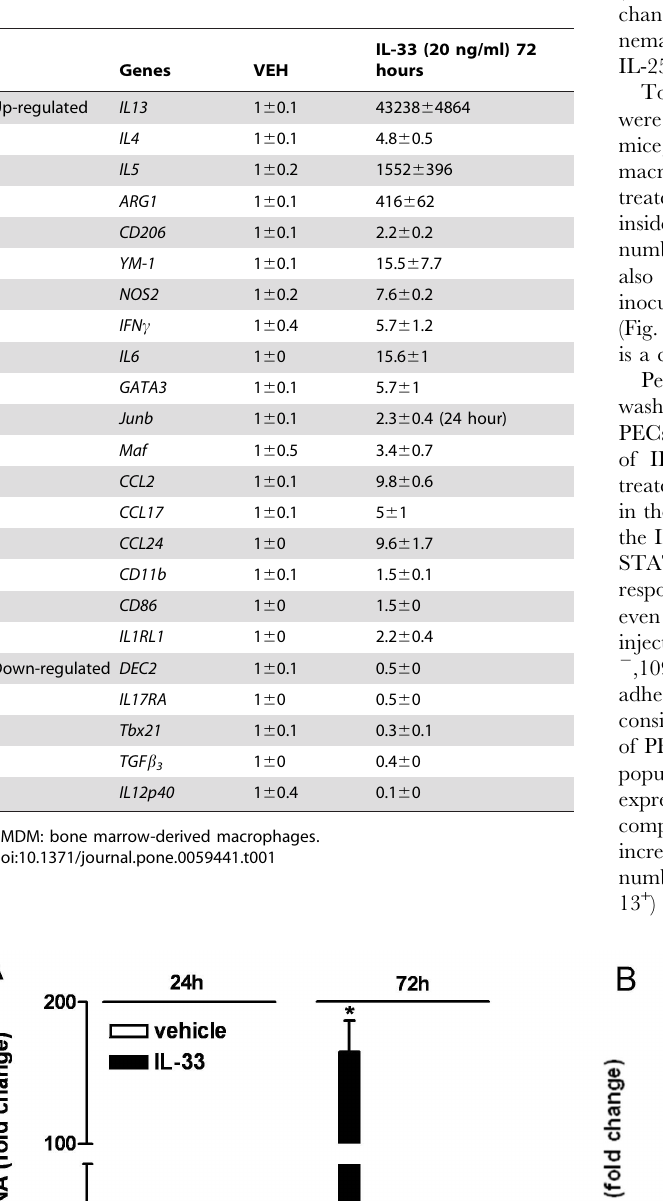
Table 1. Genes regulated by IL-33 in BMDM (mRNA expression by real-time qPCR).